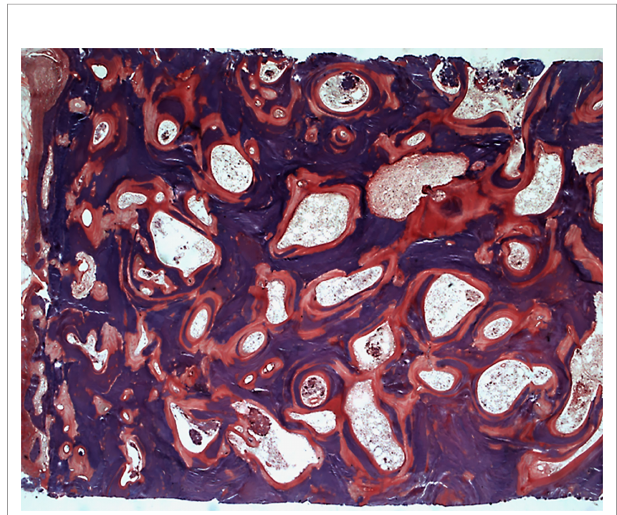
FIGURE 7 | Skeletal fl uorosis characterized by an osteosclerosis with increased osteoid surfaces and mineralization defects in the trabeculae and around the osteocyte lacunae. Solochrome cyanin R; x50.